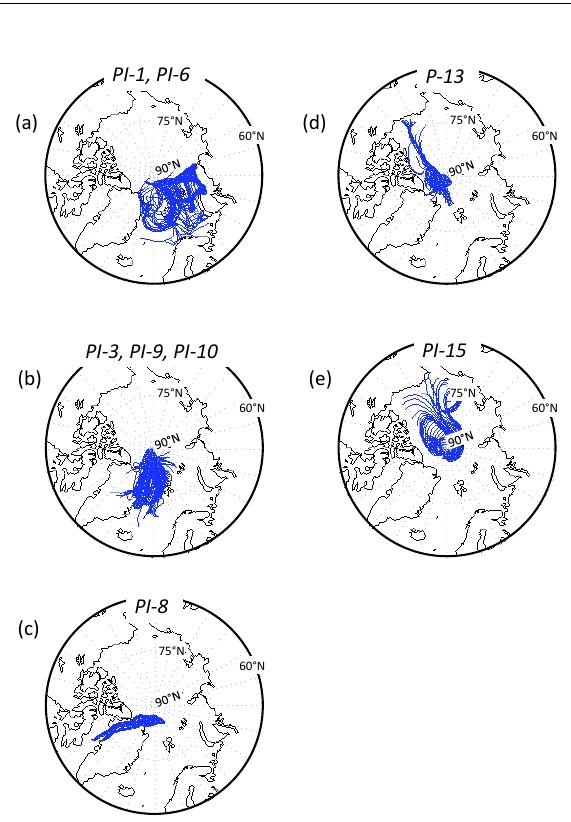
Figure 3. Air trajectory clusters with an arrival height of 100m at the position of the icebreaker during: (a) cluster 1 (DOY 227, DOY 229–232) originated easterly from the Barents and Kara seas, (b) cluster 2 (DOY 228, DOY 236, 238–239) from the Greenland Sea– Fram Strait area, (c) cluster 3 (DOY 234–235) from Greenland, (d) cluster 4 from north-western circumpolar over the pack ice during DOY 240–243, and (e) cluster 5 from north-western circumpolar over the pack ice during DOY 243–246. Table 2 gives the calculated DOI for each of the